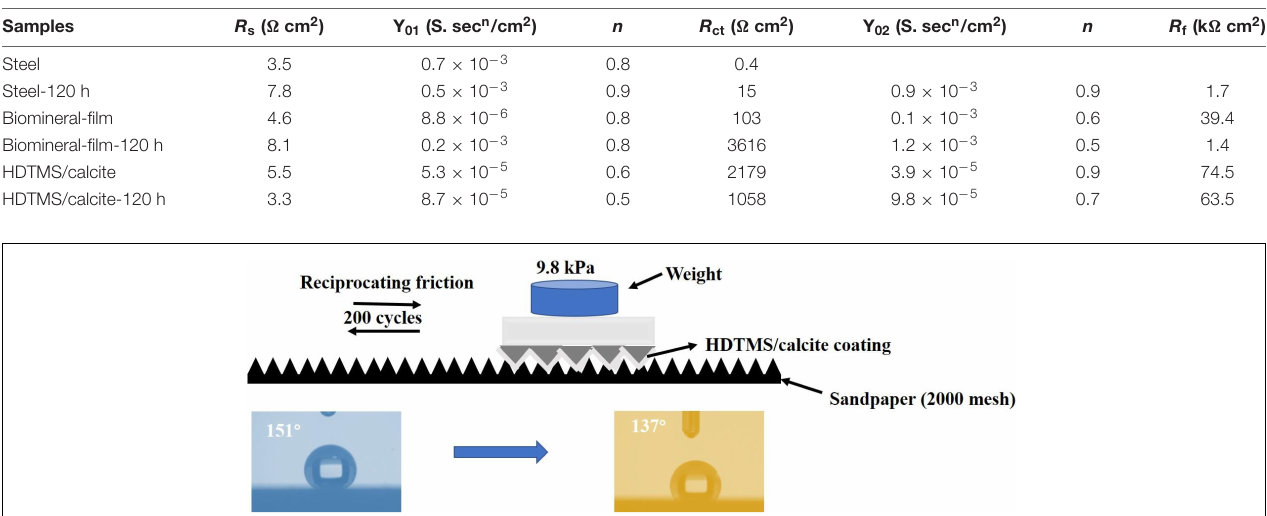
TABLE 1 | Electrochemical impedance parameters from fitted data in Figure 10 .